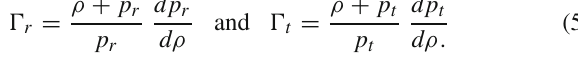
Fig. 6 In this figure, along x -axis, y -axis and z -axis we have respec- tively plotted the matter density ρ in MeVfm − 3 unit, the dimensionless quantity n which lies in the range − 200 ≤ n ≤ 200 and ∂ M ∂ρ profile is drawn for a compact star of mass M = 1 . 85 M (cid:3) and radius of the star = 9 . 5 km. by fixing b = 0 . 0095 km − 1